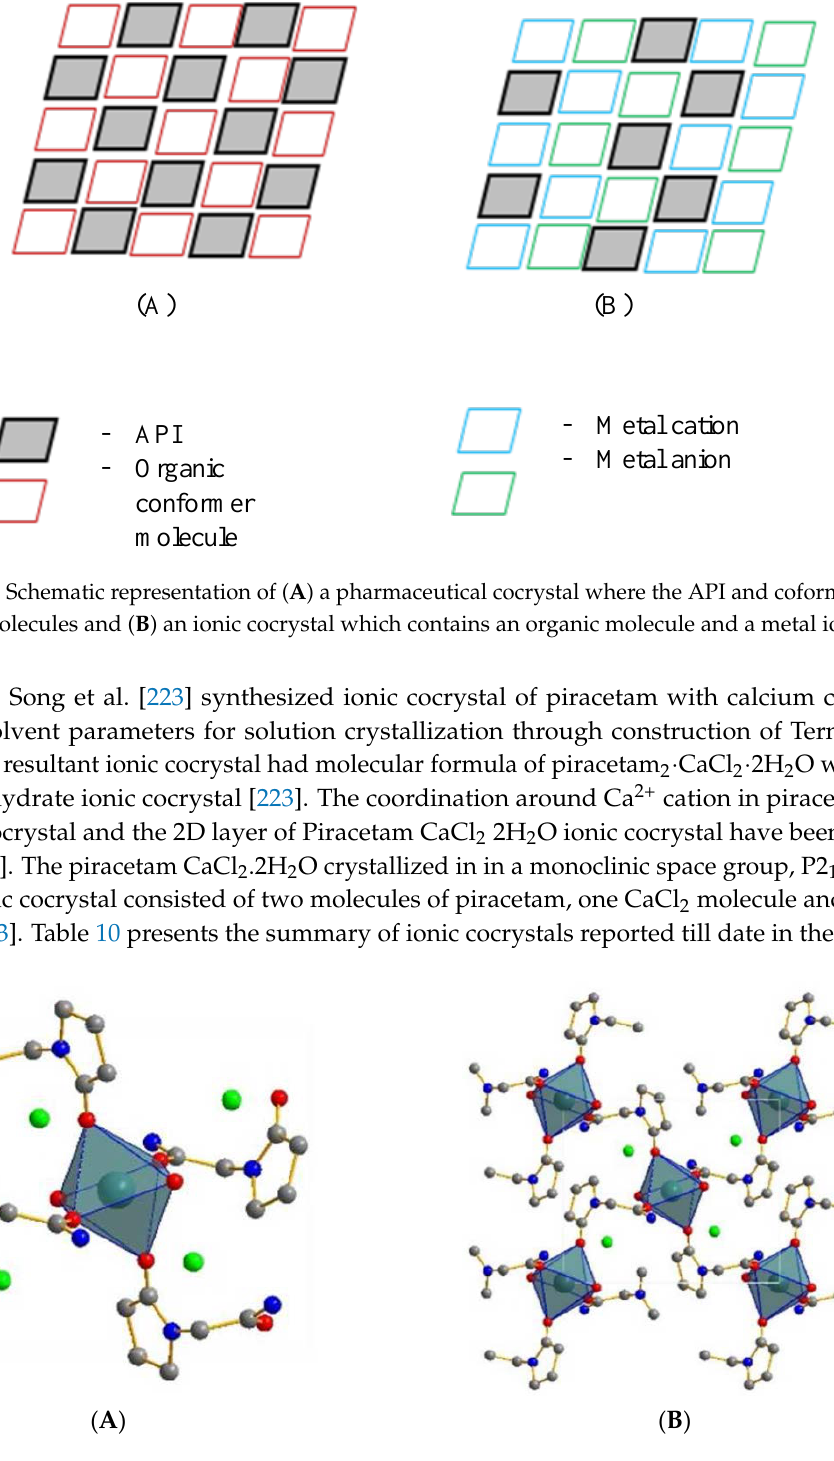
Figure 18. ( A ) Coordination around Ca 2+ cation in piracetam. CaCl 2 2H 2 O ionic cocrystal and ( B ). 2D layer of Piracetam.CaCl 2 2H 2 O ionic cocrystal [Reprinted from [223] with permission. Copyright 2018 American Chemical Society].